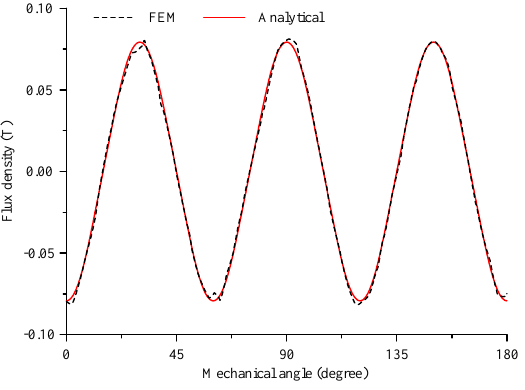
Figure 4. Flux density calculated by finite element method (FEM) and analytical model through the coils at the radius of 14 mm. Energies 2018 , 11 , x FOR PEER REVIEW